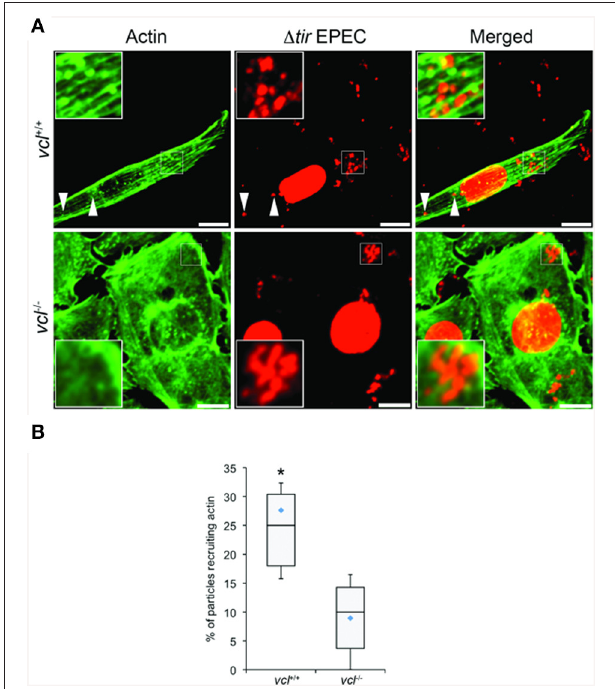
FIGURE 6 | The ability of the vinculin binding domain to recruit actin is dependent on vinculin. (A) vcl + / + and vcl − / − mouse embryo fibroblasts (MEFs) expressing the Vinculin Binding Domain (TirM-VBD) were infected with 1 tir EPEC, and the recruitment of actin monitored. Actin (green) or bacteria (false-colored red) were visualized with phalloidin or DAPI, respectively. The white arrowheads indicate colocalization of actin with 1 tir EPEC. Scale bars: 10 µ m. (B) Adhered EPEC colocalizing with actin in vcl + / + and vcl − / − MEFs were enumerated and data represented as box and whisker plot. Data compiled from three independent experiments. Plot shows range (statistical outliers excluded), first and third quartiles, and overall median (horizontal line). Diamonds show means. A range of 170–235 particles was counted per sample. Insets show a magnification of a selected area of the cell. Asterisk indicates statistical significance (One-way ANOVA, Tukey’s post-hoc test, P < 0.00001